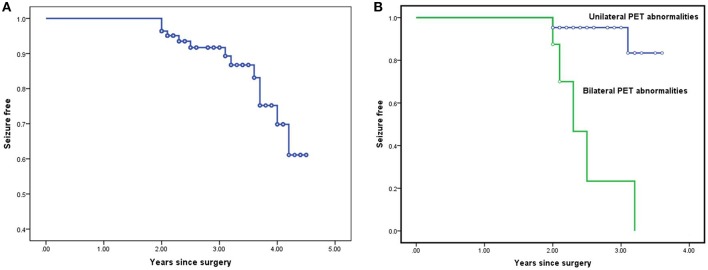
Survival curves for the entire cohort and for the subgroups in Cox proportional hazard regression model: Kaplan-Meier survival curves estimating seizure-free rates at various postoperative time intervals in the entire cohort (A). Kaplan-Meier survival analysis of the potential predictor bilateral PET abnormalities (B).